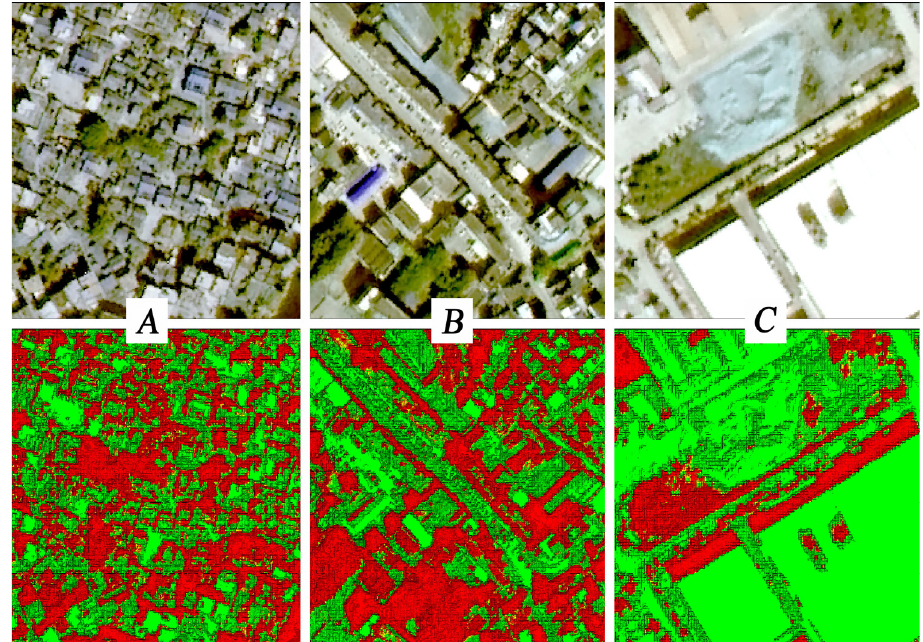
Figure 13. Detailed display of classification results of SDNF methods. Red represents the canopy coverage area; green represents the other land coverage area. ( A ) Urban residential region; ( B ) urban road region; ( C ) urban large building region.